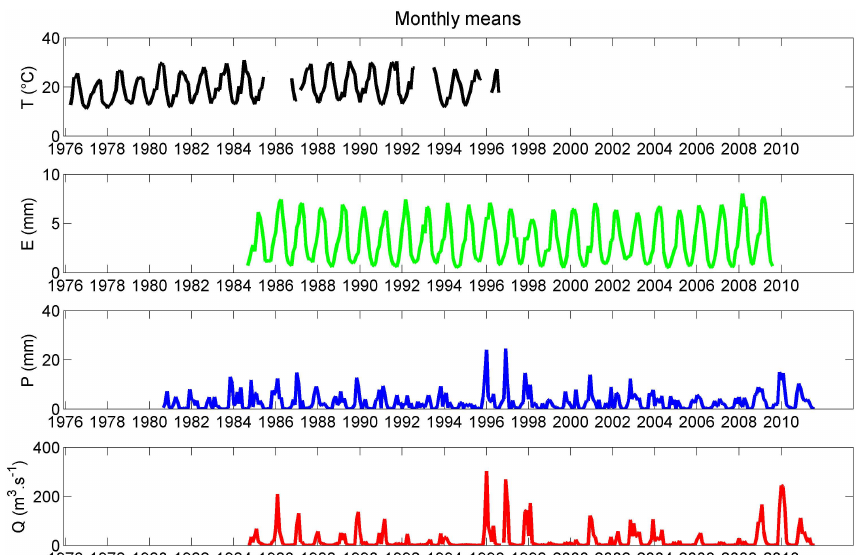
Fig. 2. Monthly mean air temperature, pan evaporation, precipitation and discharge for the full length of records